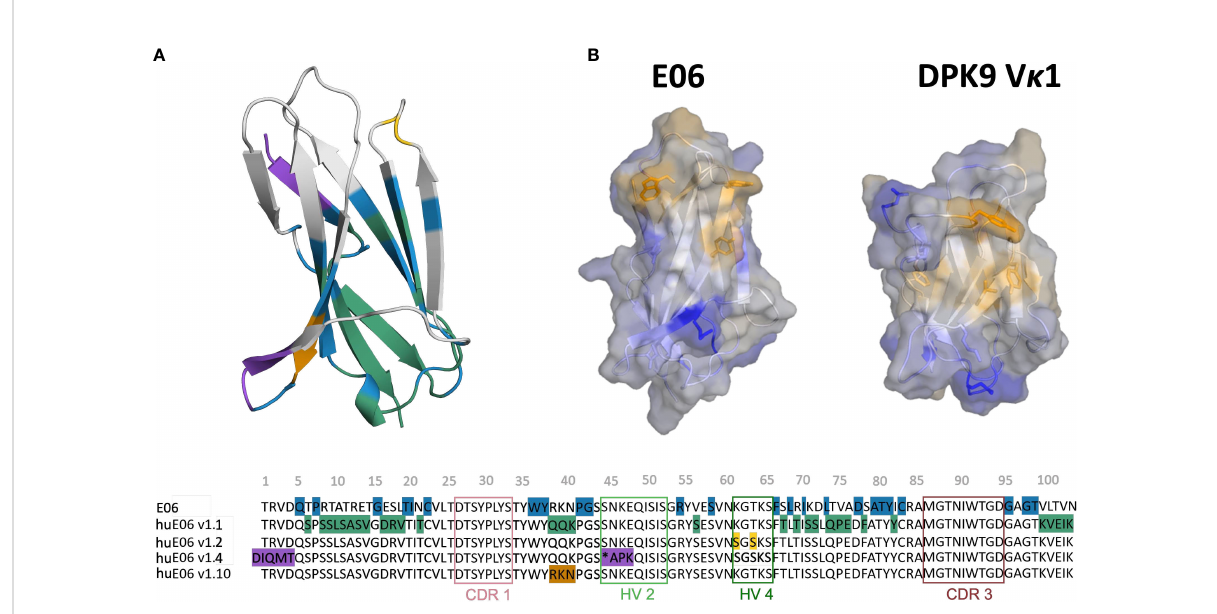
FIGURE 2 Sequence alignment highlighting the differences between the VNAR variants. (A) Color-coded sequence alignment showing the introduced changes upon antibody humanization. The changes in the sequences are also highlighted in the structure. The residues that are identical with the DPK9 germline are colored in blue, the mutated residues in variant huE06 v1.1 are colored in green. Additional mutations of variants huE06 v1.2, v1.4 are depicted in yellow and purple, respectively. The huE06 v1.10 variant, restoring critical ‘ RKN ’ motif, is shown in orange. (B) Surface